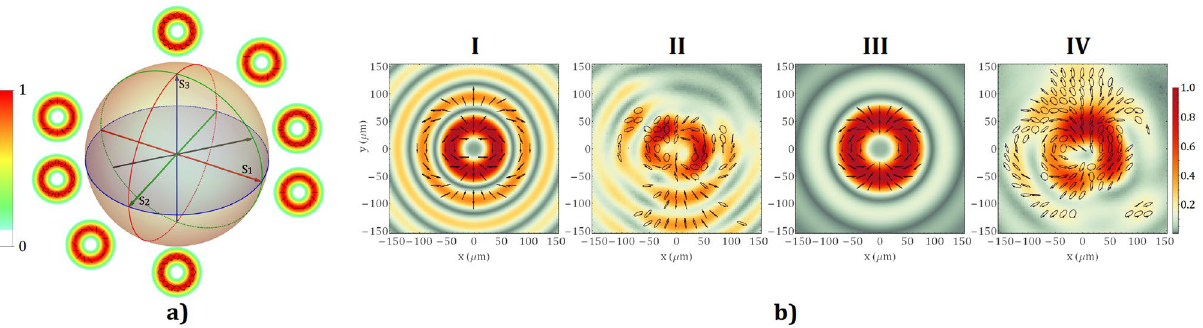
Figure 3. ( a ). Theoretical intensity and polarization distributions in the transverse plane for VBs with m = ± 2 are represented on the Poincaré sphere. ( b ) The polarization map and the intensity distribution of the theoretical (I and III) and experimental results (II and IV) for a VBS that has a Sapphire crystal with 5.44 mm thickness and the incident beam is delivered by the oscillator (I and II) and by the high-power laser system (III and will provide an overall linear polarization state with a spatially variable direction. The intensity and polarization distribution for these cases are shown in Fig. 3a. By calculating the Stokes parameters of the electric field, we map the distributions of spatially variant states of polarization. In Fig. 3b are represented polarization ellipses for a vertically polarized input laser beam provided by the CW Ti:Sapphire oscillator and by the high-power laser system, respectively, as well as the theoretical results for the propagation through the optical system of the Gaussian laser beam. The intensity (S 0 ) is shown using false colours. The angle of orientation of the major semi-axis of the polarization ellipse and the degree of ellipticity were calculated from the Stokes parameters. Ellipses were rendered for an intensity threshold above 0.3 from the maximum value. For the simulations, the polarization state is indicated using ellipses that correspond to the electric field calculated using the formula provided in Eq. (9). One can notice that the experimental result for the oscillator beam (Fig. 3bII) shows an intensity distribution characteristic for an m = 2 doughnut vortex beam. The Bessel rings in the focal plane of the lens L 4 are due to the thin ring like-shape of the beam intensity profile incident on it. We know that the Fourier transform of the Bessel beam is an infinitely thin ring, thus we can expect that the thinner the ring-like intensity distribution in the plane of L 4 is, the more distinguishable the Bessel rings will be. In addition, a residual conical phase will be present if the beam incident on the VBS is not perfectly collimated. This will also cause Bessel rings in the focal plane. The central singularity with m = 2 is split into two m = 1 singularities. This is most likely due to the pres- ence of a moderate fraction of a non-vortex beam, which does not have zero intensity on the optical axis. The authors have studied the diffraction pattern generated by the illumination of an SPP with a laser beam whose wavelength is different from the design wavelength of the SPP 35 . The resulted beam is a collinear overlap between a non-vortex mode and multiple vortex modes, the most intense of which is that with the same topological charge as the SPP. Their superposition causes the split of the singularity point into a number of singularities that is equal to the topological charge of the SPP. We know for a fact that the polarization conversion efficiency is not exactly 100% for our system because the crystal thickness is not 5.3 mm, thus the residual m = 0 mode is present. Furthermore, the focal spot is sensitive to the alignment of the beam along the optical axis of the VBS. Thus, the small misalignments in the optical setup may contribute to this phenomenon as well. For instance, the astigmatic transformation of vortex beams is often used to analyse the order of the topological charge 36 . We know from the previously mentioned paper that the presence of astigmatism will produce a maximum intensity on the optical axis for even topological charges. For linear input beam polarization on the crystal, we expect a VVB with linear polarization as it is shown in Fig. 3bI and III. However, elliptical polarization was also observed, most likely because of the uncertainty in the alignment of the fast axis of the QWP from PCS to achieve linear input polarization or of the axis of the QWP from PAS for the measurement of the polarization. On the other hand, if we introduce the SPPS into the optical system, the generation of HVBs is realized by an overlapping of the modes with topological charges m = 1 and m = − 3. Their intensity and polarization distribu- tions are illustrated in Fig. 4a. As in the previous case, scalar vortex modes are obtained for circular polarization. For a right-handed circular input polarization, the topological charge of the optical vortex is 1 (Fig. 4b column I) and for the inverted polarization state, m = − 3 was achieved (Fig. 4b column II). A mixture of around 50% energy from each mode generates an HVB with an intensity profile depicted in Fig. 4b, Column III. The polari- zation state is characterized by a left-handed circular polarization around the singularity point determined by the polarization state of m = 1 mode which has the highest intensity near the optical axis. Farther from the axis, the local polarization passes from linear to elliptical with opposite handedness due to the influence of the vortex mode with m = − 3. We will further investigate a more complex case when a Laguerre–Gauss beam is incident on the VBS com- prising of a 2.72 mm thickness Sapphire crystal. For this value of the crystal thickness, the conversion efficiency of polarization is nearly η = 50% (Fig. 1b). Accordingly, 50% of the energy of the beam preserves its initial polarization state and the topological charge m = − 1, and 50% will be a combination of m = 1 and m = − 3 modes with a left, respectively right-circular polarization states. However, the weight of these two modes will depend on the input polarization state and can be 0 for some of the modes in the case of right or left-handed circular polarization. The generated focal spots presented in Fig. 5, column (I) and column (II) show the theoretical and